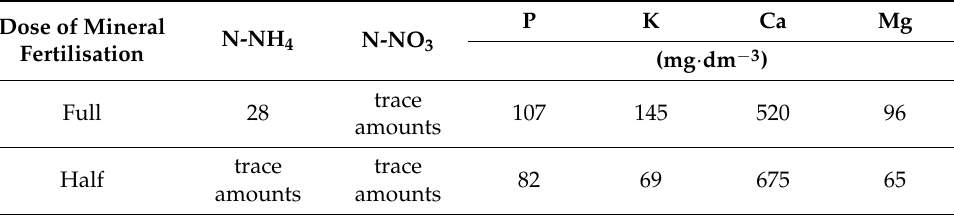
Table 2. The contents of soluble forms of N-NH4, N-NO3, P-PO4, K, Ca, and Mg in nursery soil (mean values for 2017–2018).